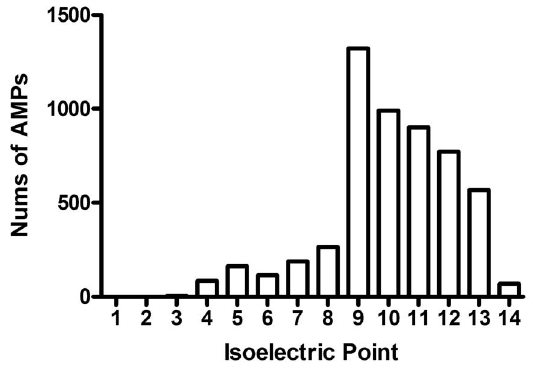
Figure 3. Distribution of calculated isoelectric points for the AMPs in LAMP. Every bar indicates the number of AMPs calculated to have their isoelectric point range from pI-1 to pI.